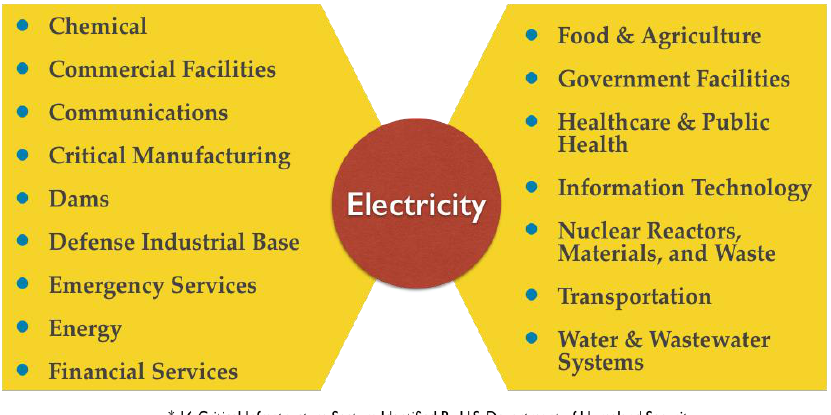
Figure 1. All Critical Infrastructure is dependent on the availability of electricity (Source: S. R. Greene, Advanced Technology Insights,